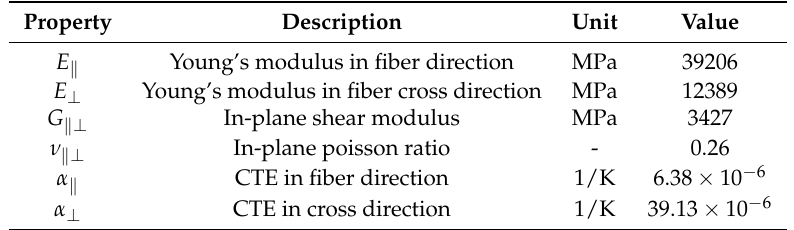
Table 2. Applied material parameters for the calculation of the residual stress in fiber direction. Property